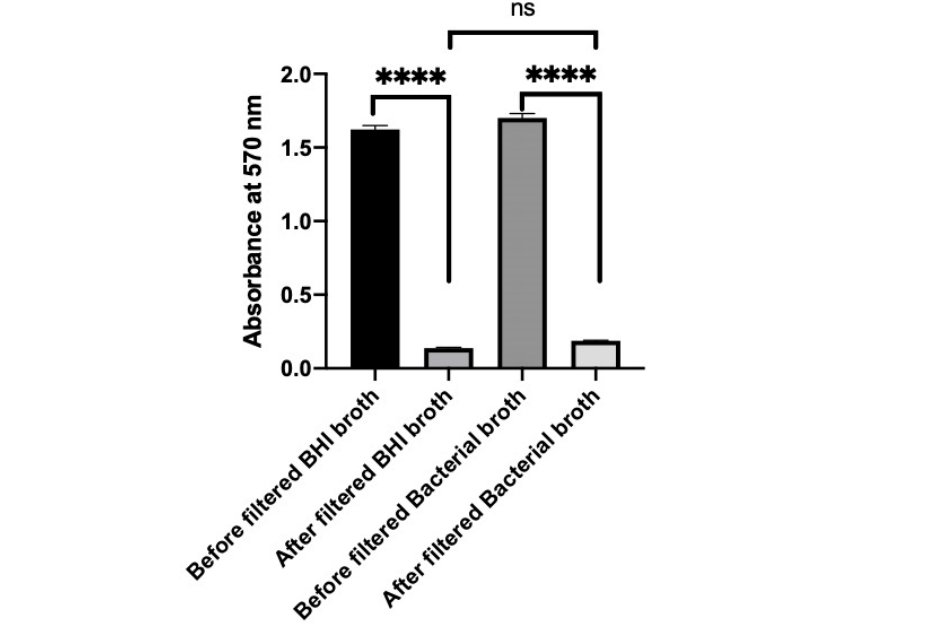
Figure 3. The optical density results of the BHI broth before (isopropanol dissolving) and after (column chromatography) filtering, and S. aureus suspension. Bacterial broth before filtering: S. aureus suspension dissolved in isopropanol; BHI broth before filtering: pure BHI broth dissolved in isopropanol; bacterial broth after filtering: S. aureus suspension obtained after column chromatography filtration; BHI broth after filtering: pure BHI broth obtained after column chromatography filtration. Results are expressed as the mean ± SD. Quadruple asterisks (****) indicate p < 0.0001. ns indicates p > 0.05.